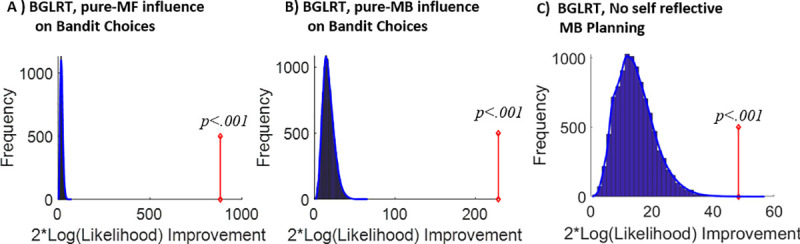
Model-comparison results.A) Results of the bootstrap-GLRT model-comparison for the pure MF-influence on bandit choices sub-model. The blue bars show the histogram of the group twice log-likelihood improvement (model vs. sub-model) for synthetic data that was simulated using the sub-model (10001 simulations). The blue line displays the smoothed null distribution (using Matlab’s “ksdensity”). The red line shows the empirical group twice log-likelihood improvement. 0 out of the 10001 simulations yielded an improvement in likelihood that was at least as large as the empirical improvement. Thus, the sub-model can be rejected with p < .001. B) Same as (A), but for the pure MB-influence on bandit choices sub-model. This sub-model was rejected with p < .001. C) Same as (A) but for the ‘No self-reflective MB planning’ sub-model. This sub-model was rejected with p < .001.